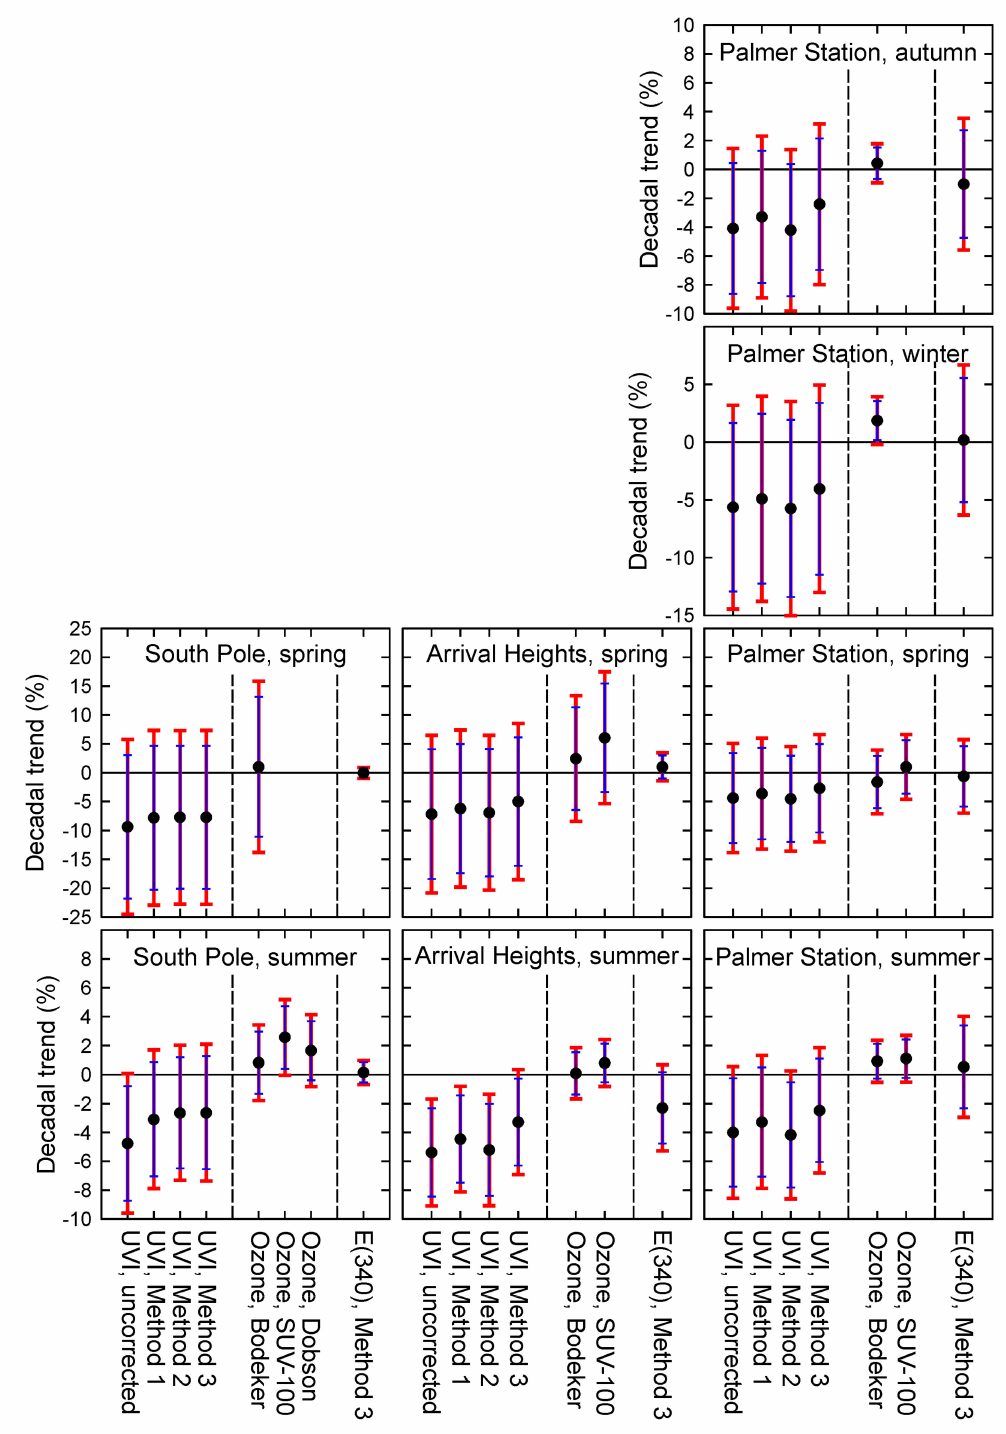
Figure 4. Decadal trends of the UV Index (UVI), total ozone column (TOC) (“Ozone”), and irradiance at 340 nm (“E(340)”) at the South Pole ( left ), Arrival Heights ( center ), and Palmer Station ( right ) for autumn (March–May, 1st row); winter (June–August, 2nd row), spring (September–November, 3rd row), and summer (December–February, 4th row). Ozone trends were calculated from the datasets by Bodeker, SUV-100, and Dobson as defined in the text. Trends in UVI were calculated from the uncorrected datasets, plus datasets corrected using Methods 1–3. Trend uncertainties are indicated at the 95% (red) and 90% (blue) level of